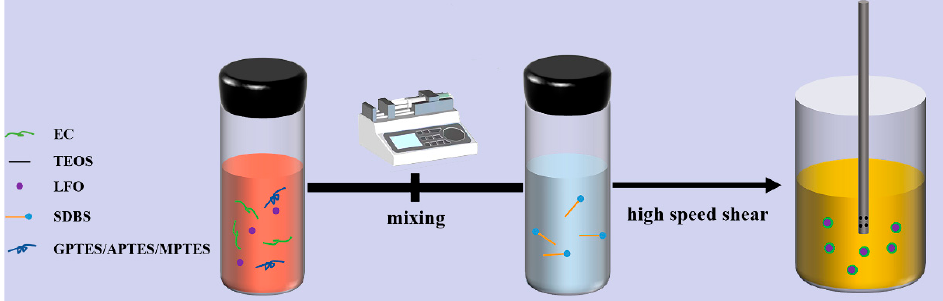
Figure 1. The schematic for ethyl cellulose/silica hybrid microcapsule. 2.3. Method of Loading Ethyl Cellulose/Silica Fragrance Microcapsules on Cotton Fabrics The cotton fabric was cut into small pieces (5 × 5 cm 2 ) with scissors. The cotton fabric was dipped into the modified EC/SiO 2 fragrance microencapsulated emulsion (solid con- tent: 10 wt%) for 1 h. After that, the dipped cotton fabric was placed in an oven at 120 °C for 30 min by a hot air oven and taken out into a PP bag after the cotton fabric was com- pletely dried.